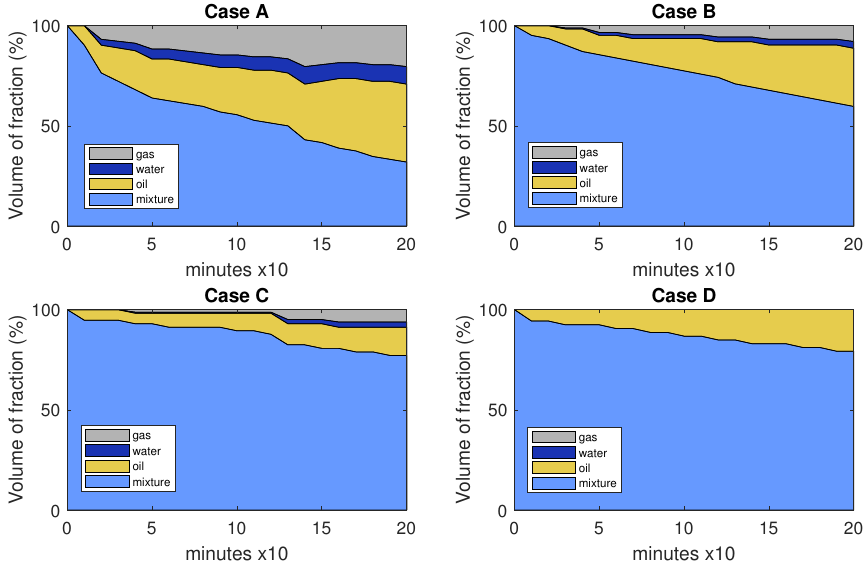
Figure 15. Mean dynamics performance in the intermediate layer over time for different cases.